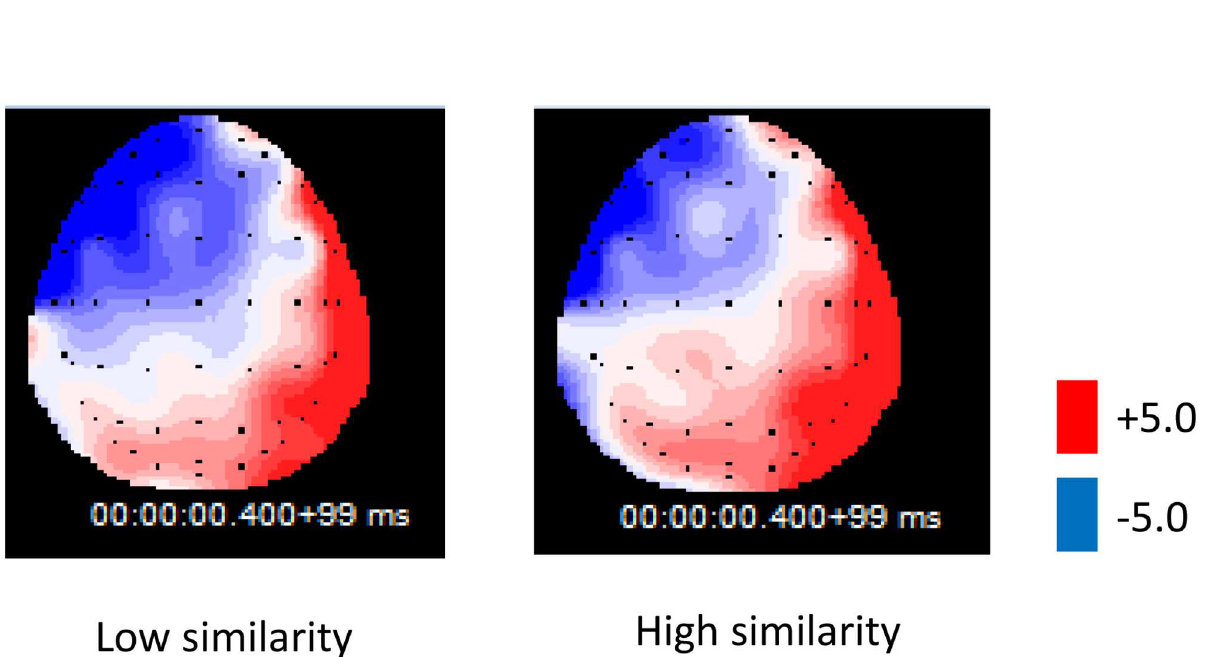
Fig 5. Topography of ERPs for the low similarity and high similarity condition